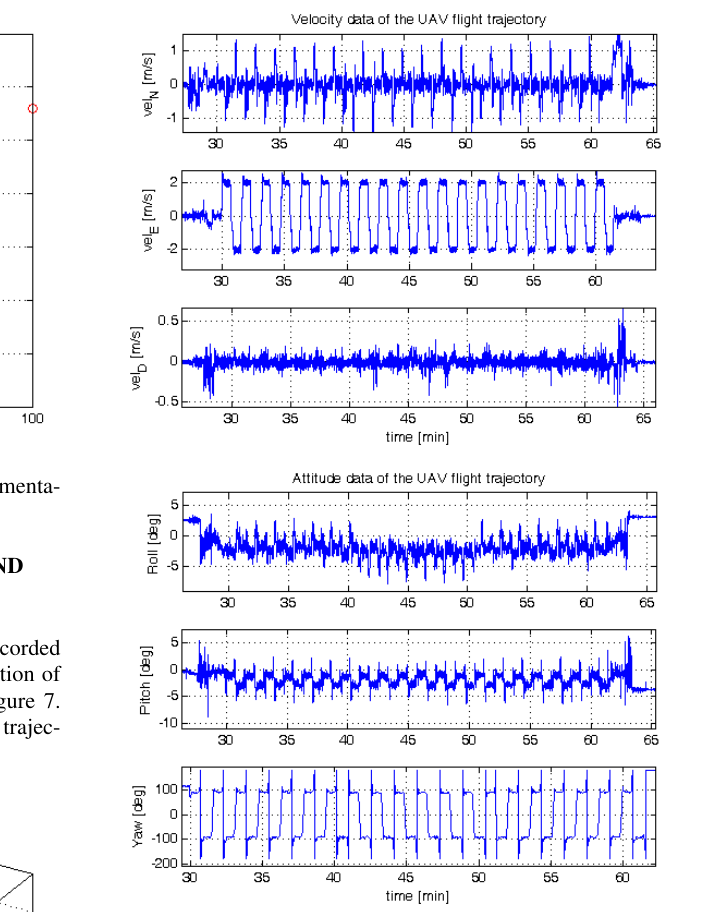
Figure 8: The actual recorded UAV velocity and attitude data during the aerial magnetic scanning